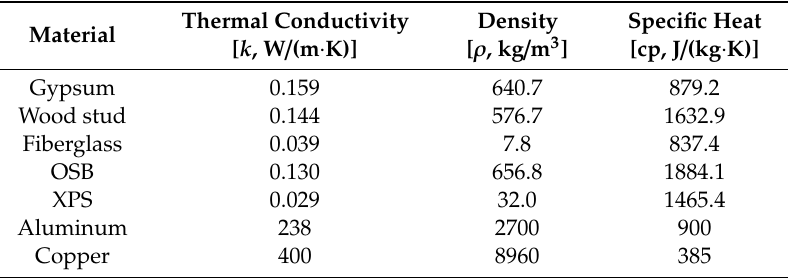
Table 1. Material properties used in the